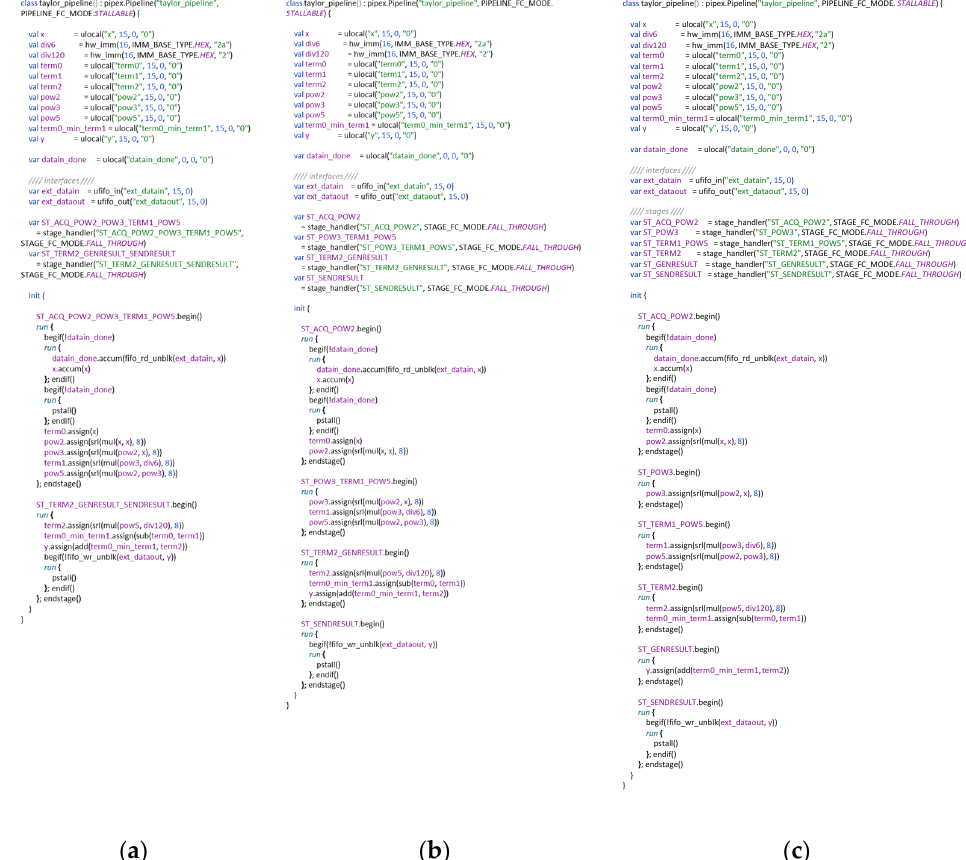
Figure 5. Example of staging options in sine wave generator based on Pipex KIP core: 2-stage ( a ), 4-stage ( b ), and 6-stage ( c ).